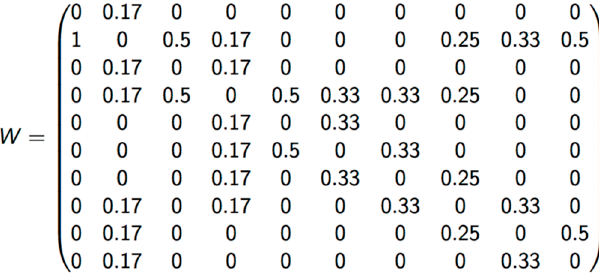
Figure 2. Standardized weight matrix.